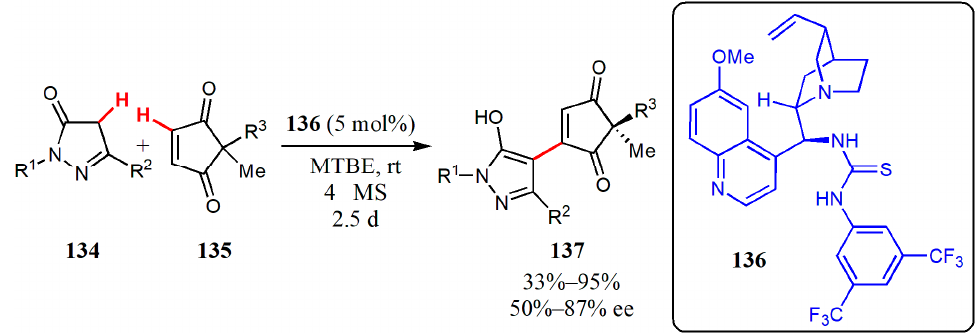
Figure 45. Desymmetrization of cyclopentenediones via organocatalytic CDC with pyrazoles.